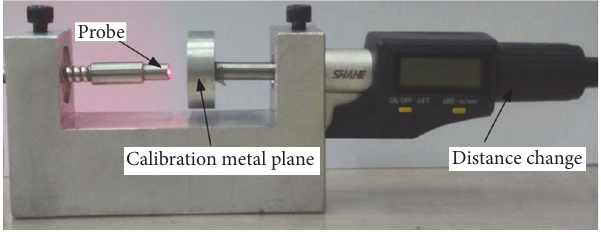
Figure 8: Displacement calibration